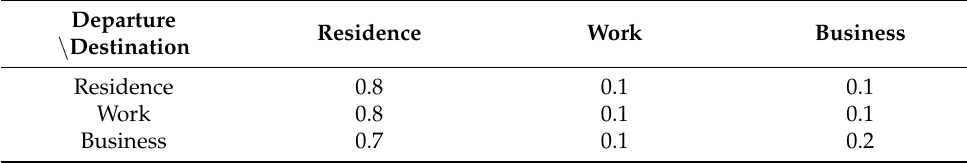
Table A3. OD matrix at 22:00~7:00 (+1) on